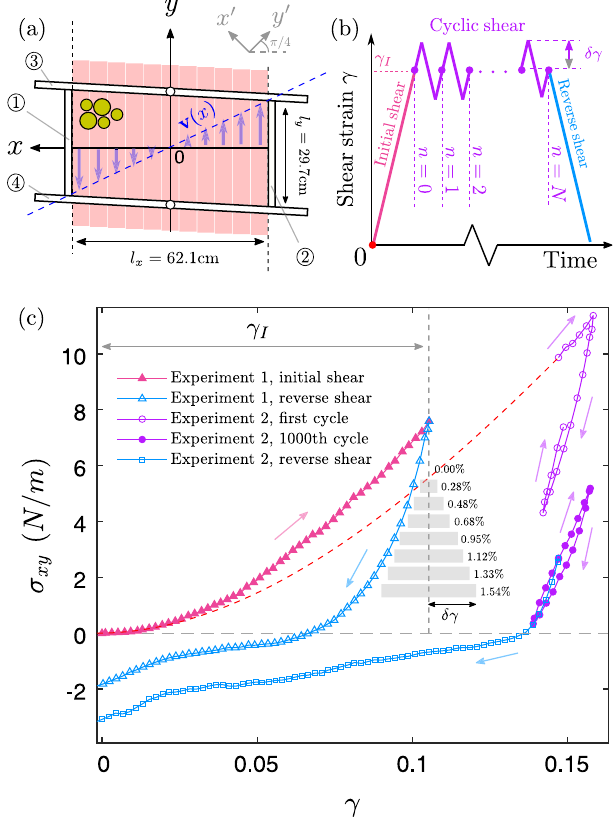
FIG. 1. (a) A top view schematic of the multislot shear cell. (b) The driving strain protocol. An initial large forward shear is followed by multiple periods of small-amplitude cyclic shear and then by large-amplitude reverse shear. The shear rate is always in the quasistatic regime. (c) Shear stress σ defined in Eq. (2) as xy functions of shear strain γ for two example experiments. Experi- ¼ 0 . 105 followed ment 1 contains an initial forward shear γ I directly by a reverse shear. Experiment 2 contains an initial shear ¼ 0 . 147 followed by (sketched by the red dashed curve) up to γ I a series of cyclic shear with δγ ¼ 0 . 95% and then a reverse shear. For experiment 2, only the responses in the first and the 1000th cycle are plotted. The gray boxes display all the cyclic strain amplitudes used in the cyclic shear